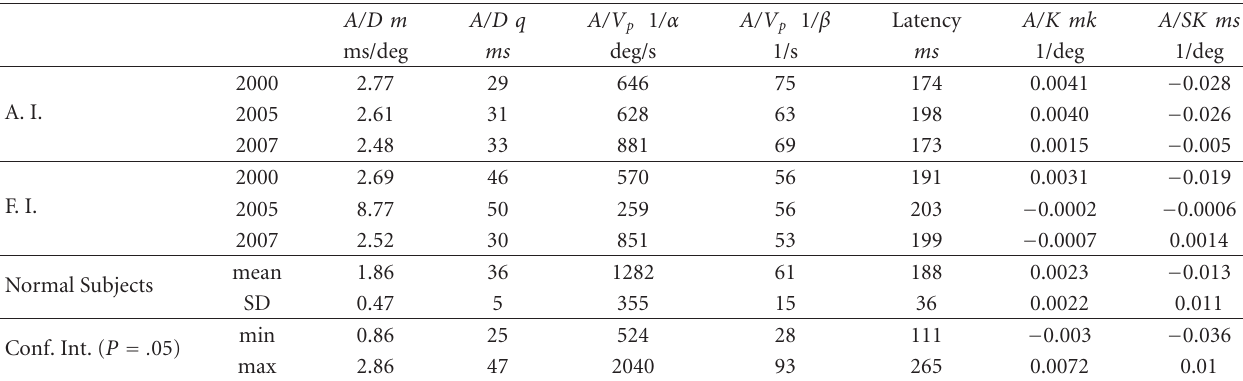
Table 1: Eye movement characteristic parameters in the two GD sisters (A. I. and F. I.) compared to mean values and SD of 10 normal subjects (and corresponding confidence interval at P = . 05). A/D m : slope of the amplitude/duration linear relationship; A/D q : intercept of the amplitude/duration linear relationship; A/V p 1 /α : velocity saturation value of the non linear amplitude/peak velocity relationship; /β : slope at the lowest amplitude of the non linear amplitude/peak velocity relationship; A/K mk : slope of the linear amplitude/ K A/V p 1 ratio relationship; A/SK ms : slope of the linear amplitude/skewness